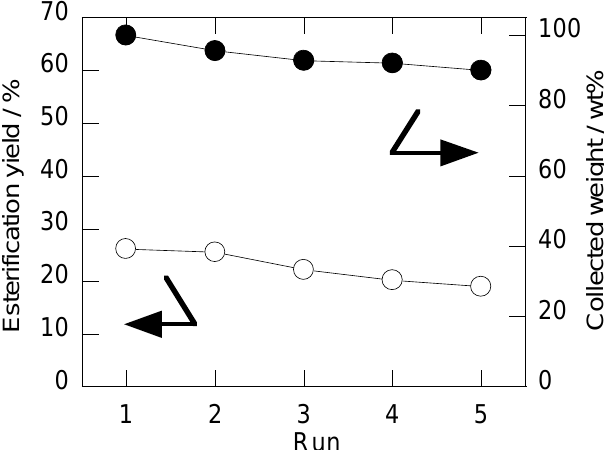
Figure 5. Esterification yields with the fresh catalyst (1st run) and the recycled catalysts (second to fifth run), and the relative amounts of catalyst against the first run. Conditions were identical to those in Table 1, but the catalyst amount was 60 mg and the reaction period was 2.5 h [9].